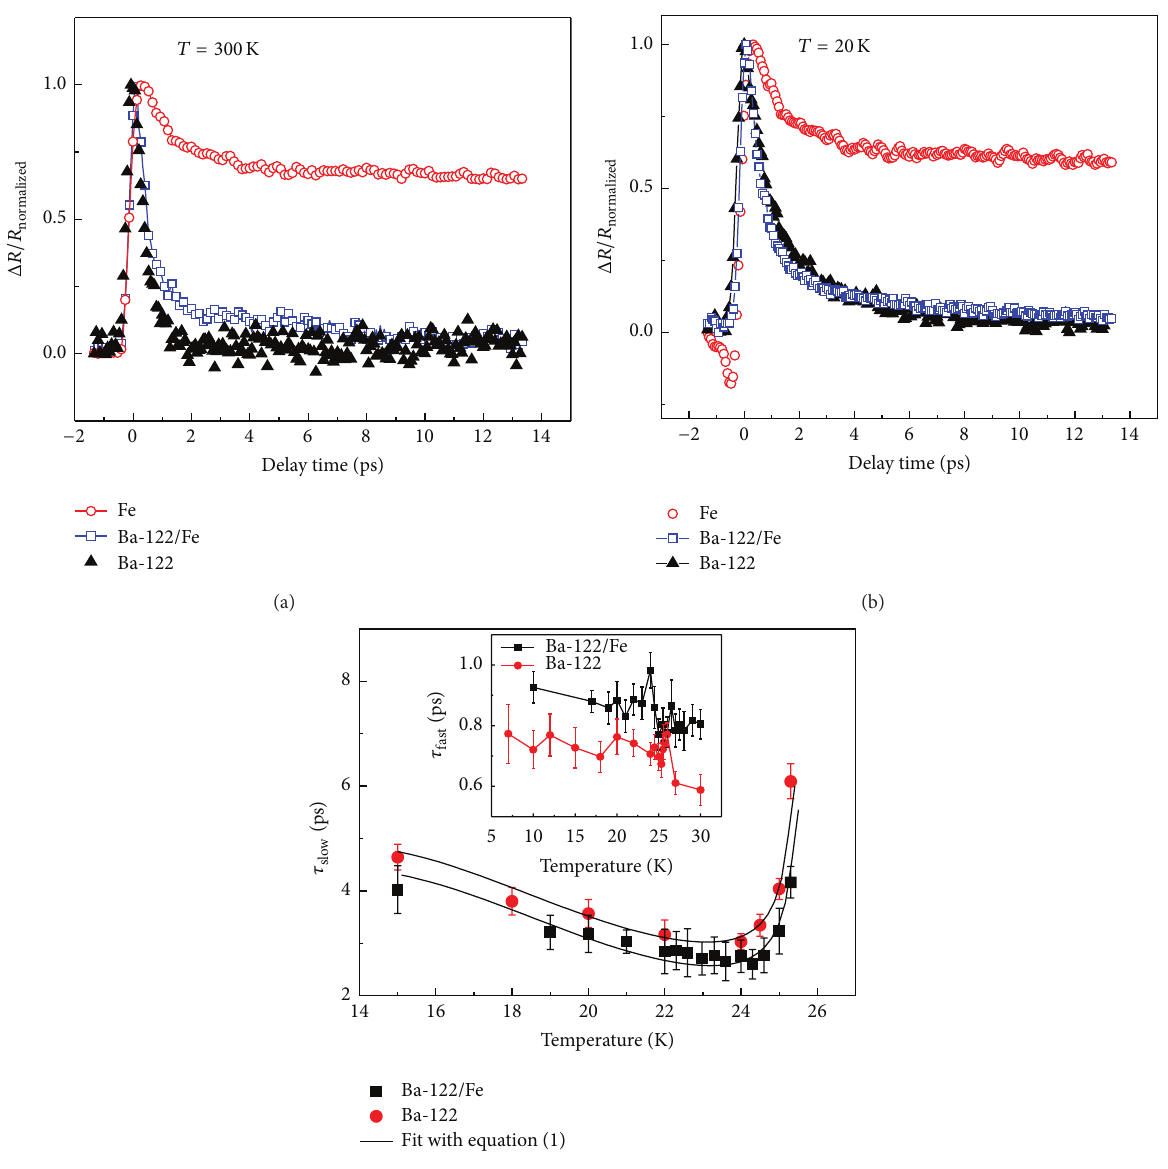
Figure 4: Normalized transient reflectivity of Ba-122/CaF 2 , Ba-122/Fe/MgO, and Fe/MgO thin films at 300 K (a) and 20 K (b); (c) the 𝜏 slow divergence-like behaviour for the two thin films. The solid lines represent the best fit of (1); inset: 𝜏 fast versus temperature for the same two